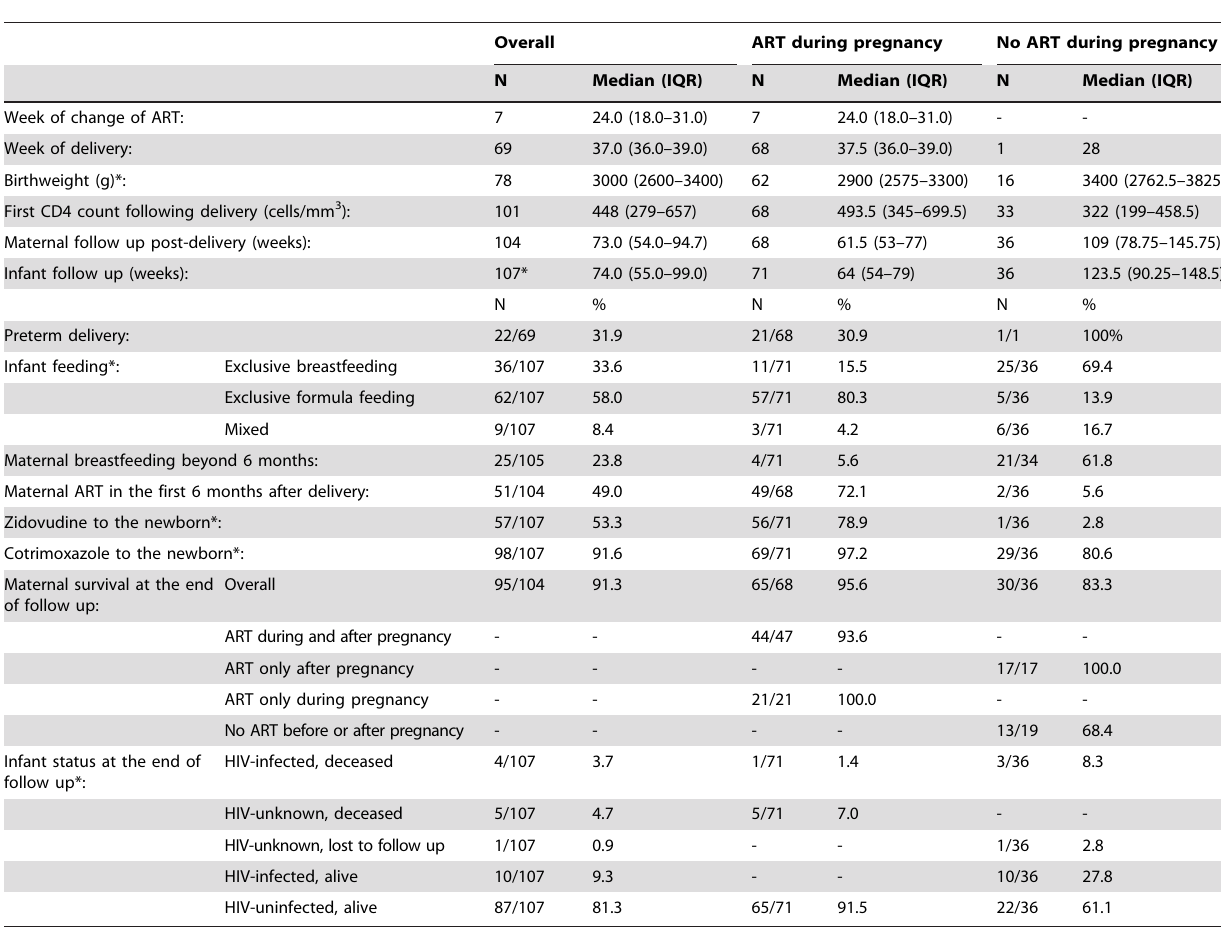
Table 2. Follow up and